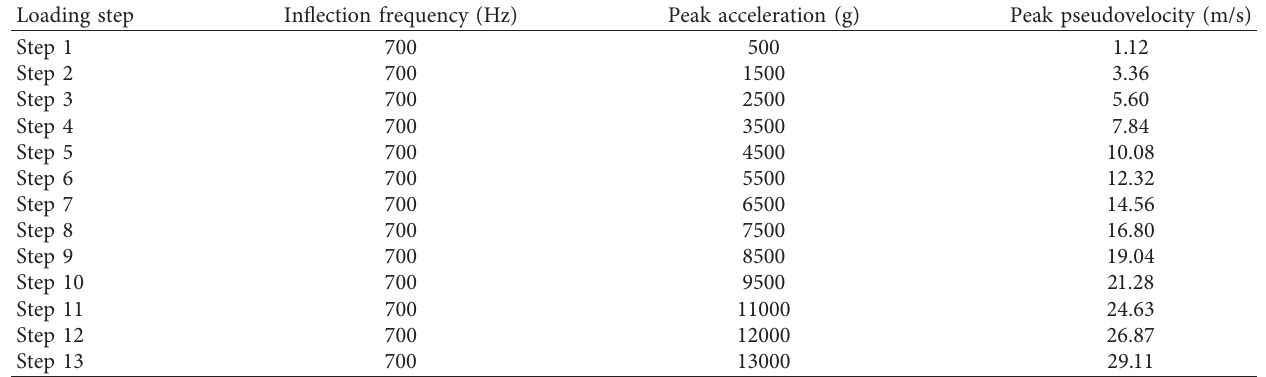
Table 1: Shock loads on C1.